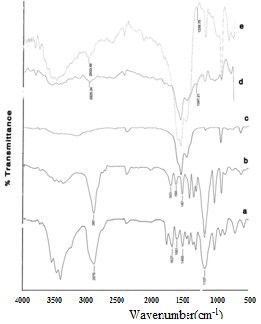
FTIR spectra for DEGPEGylated nanoparticles. FTIR spectra of (a) mPEG-silane550 powder, (b) mPEG-silane2000 powder, (c) a commercial SPGO powder, (d) mPEG-silane550-coated Gd2O3 nanoparticles, and (e) mPEG-silane2000-coated Gd2O3 nanoparticles.